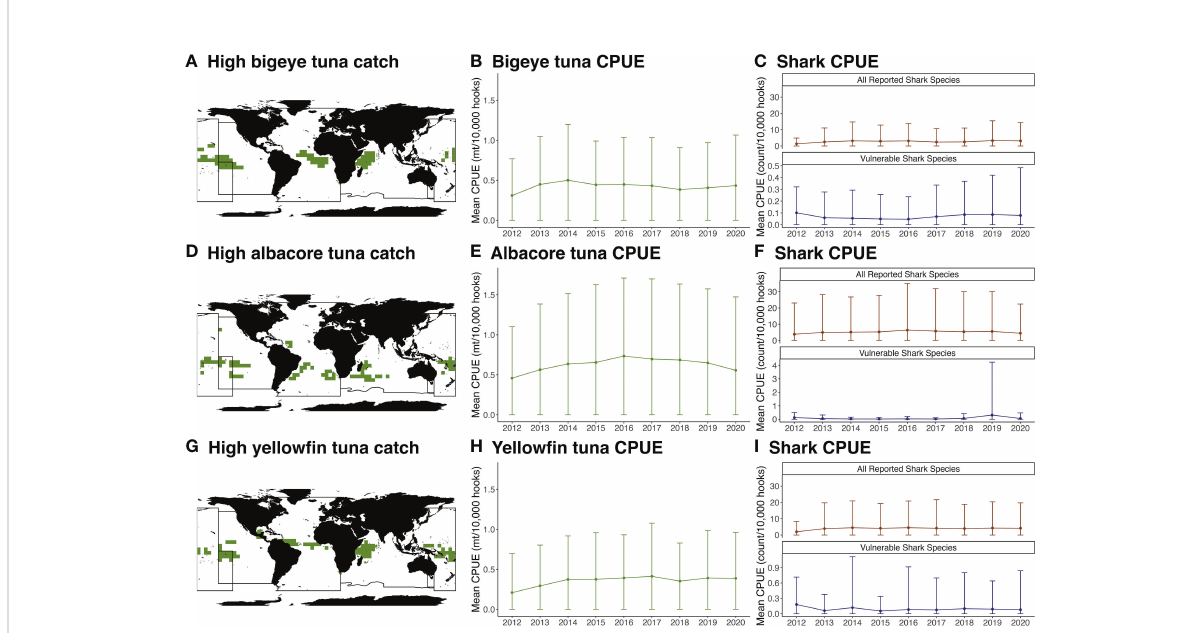
FIGURE 2 Overlap between areas of high tuna catch and shark catch. Areas in each tRFMO greater than or equal to the 90% quantile for mean annual longline catch of target species: (A) bigeye tuna, Thunnus obesus , (D) albacore tuna, Thunnus alalunga , and (G) yellow fi n tuna, Thunnus albacares . The mean (dots) and standard deviation (error bars) of catch per unit effort (mt/10,000 hooks) for target species in those regions for (B) bigeye tuna, (E) albacore tuna, (H) yellow fi n tuna. The mean (dots) and standard deviation (error bars) of catch per unit effort (count/10,000 hooks) of all reported shark species and threatened shark species (Critically Endangered, Endangered, and Vulnerable by the IUCN) in those regions (C, F, I) . Black lines in panels ( A, D , G ) represent tRFMO boundaries. Note that WCPFC shark catch data were not reported in